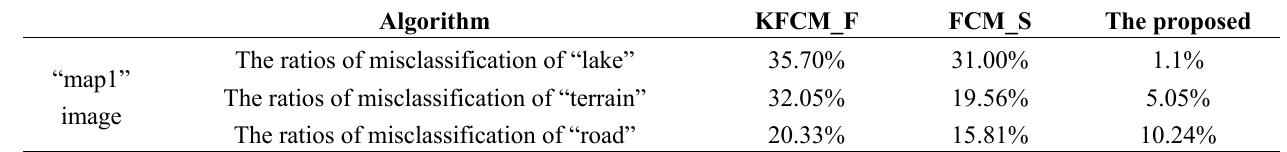
Table 1. The ratio of misclassification of difference